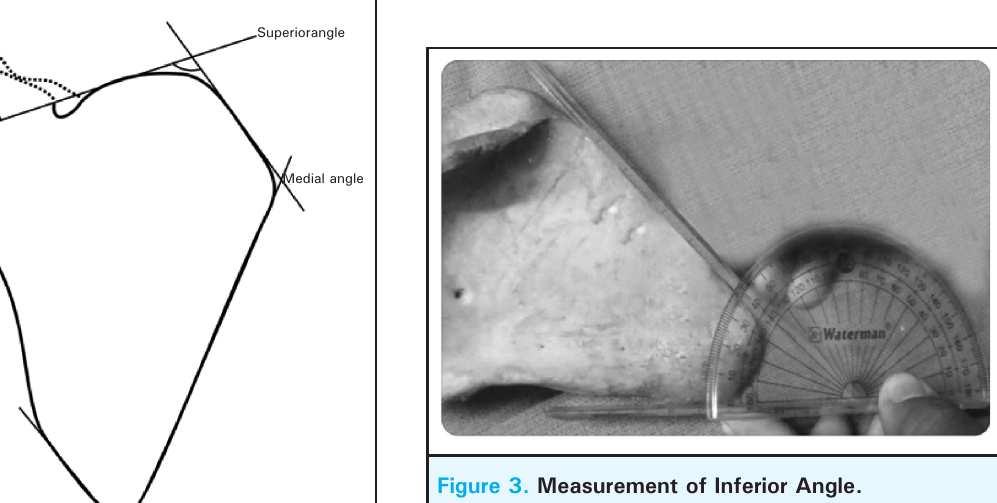
Figure 2. Measurement of Superior Angle. 2. Inferior angle: It was measured as the angle where the medial or the vertebral border of the scapula meets the lateral or the axillary border. 2 For measuring this angle the scale was placed along the medial border of the scapula and another scale was placed along the lateral border of the scapula. Then angle between the two scales was measured with the help of the protractor (Figure 1 and 3).